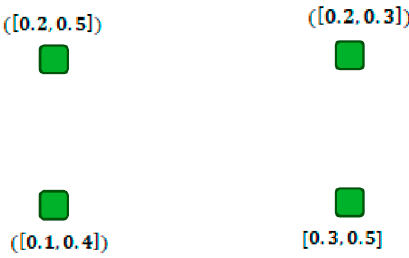
Figure 10. Complement of Figure 8.